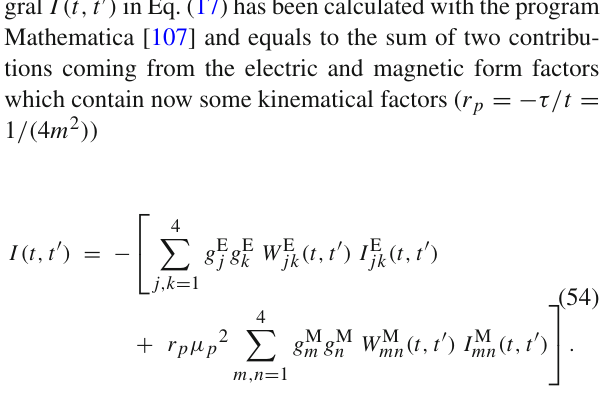
( t ) , G BO ( t ) , G BN ( t ) and G D G PU E,M E,M E,M parison in Figs. 13 and